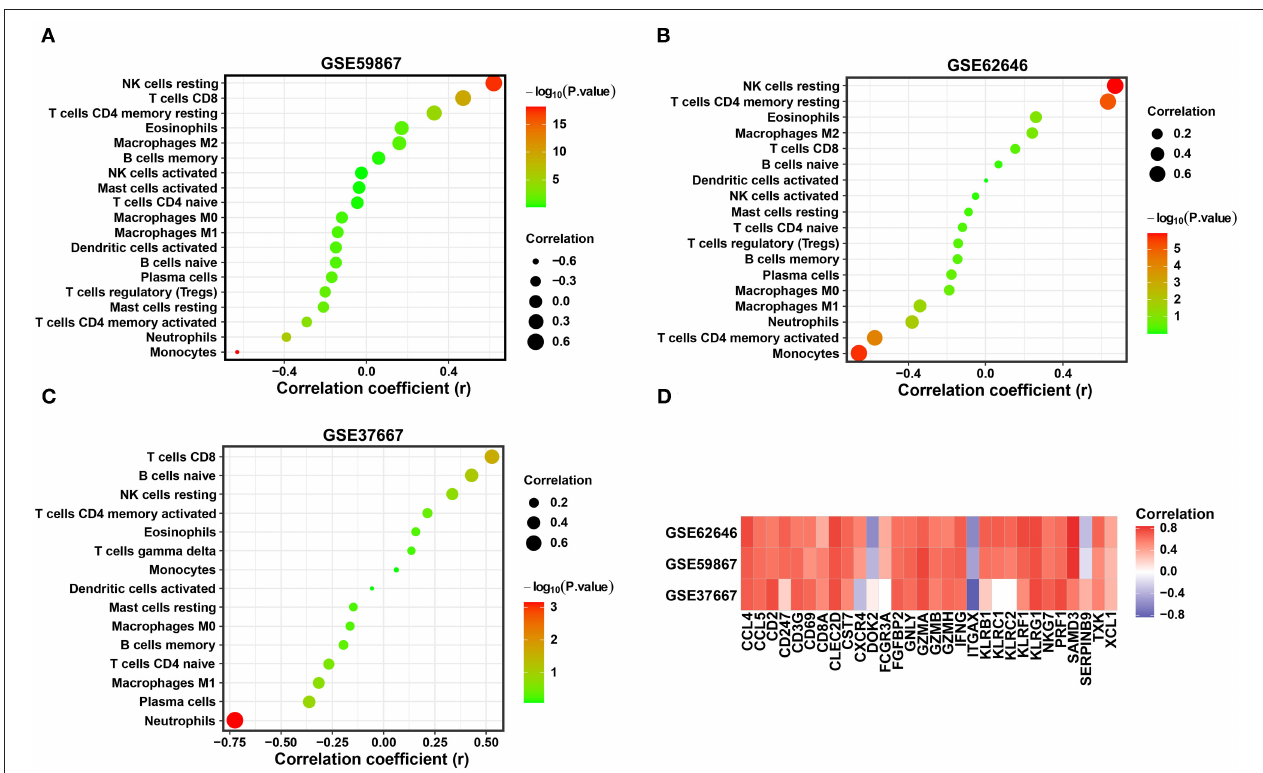
FIGURE 7 | Correlation between the expression level of SYTL2 and enriched immune cells. (A) Correlation between the expression level of SYTL2 and enriched immune cells in the GSE59867 dataset. (B) Correlation between the expression level of SYTL2 and enriched immune cells in the GSE62646 dataset. (C) Correlation between the expression level of SYTL2 and enriched immune cells in the GSE37667 dataset. The size of the dots represents the strength of the correlation between SYTL2 and immune cells; the color of the dots represents the P -value; the greener the color, the larger the P -value; and the red the color, the lower the P -value. P < 0.05 was considered statistically significant. (D) Heatmap showing the correlation between SYTL2 and the marker genes of NK